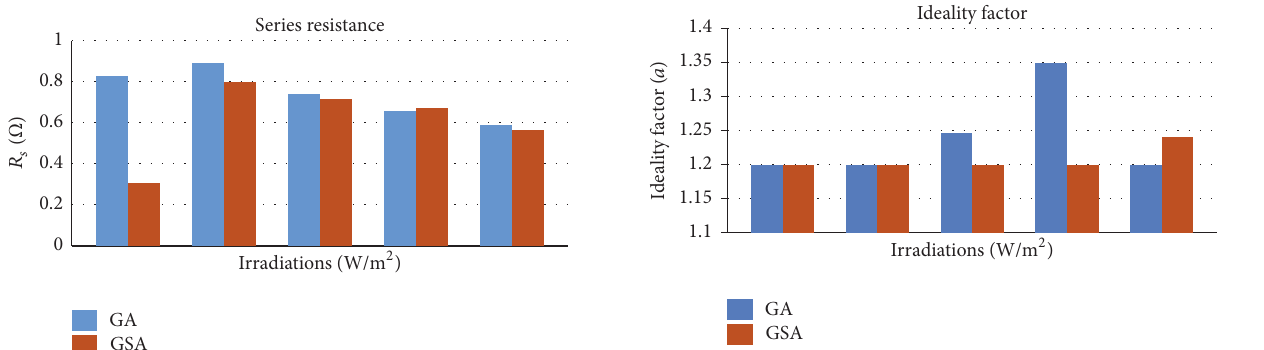
Figure 4: Comparison of the optimized series resistance values of Shell S36 under different irradiance conditions.